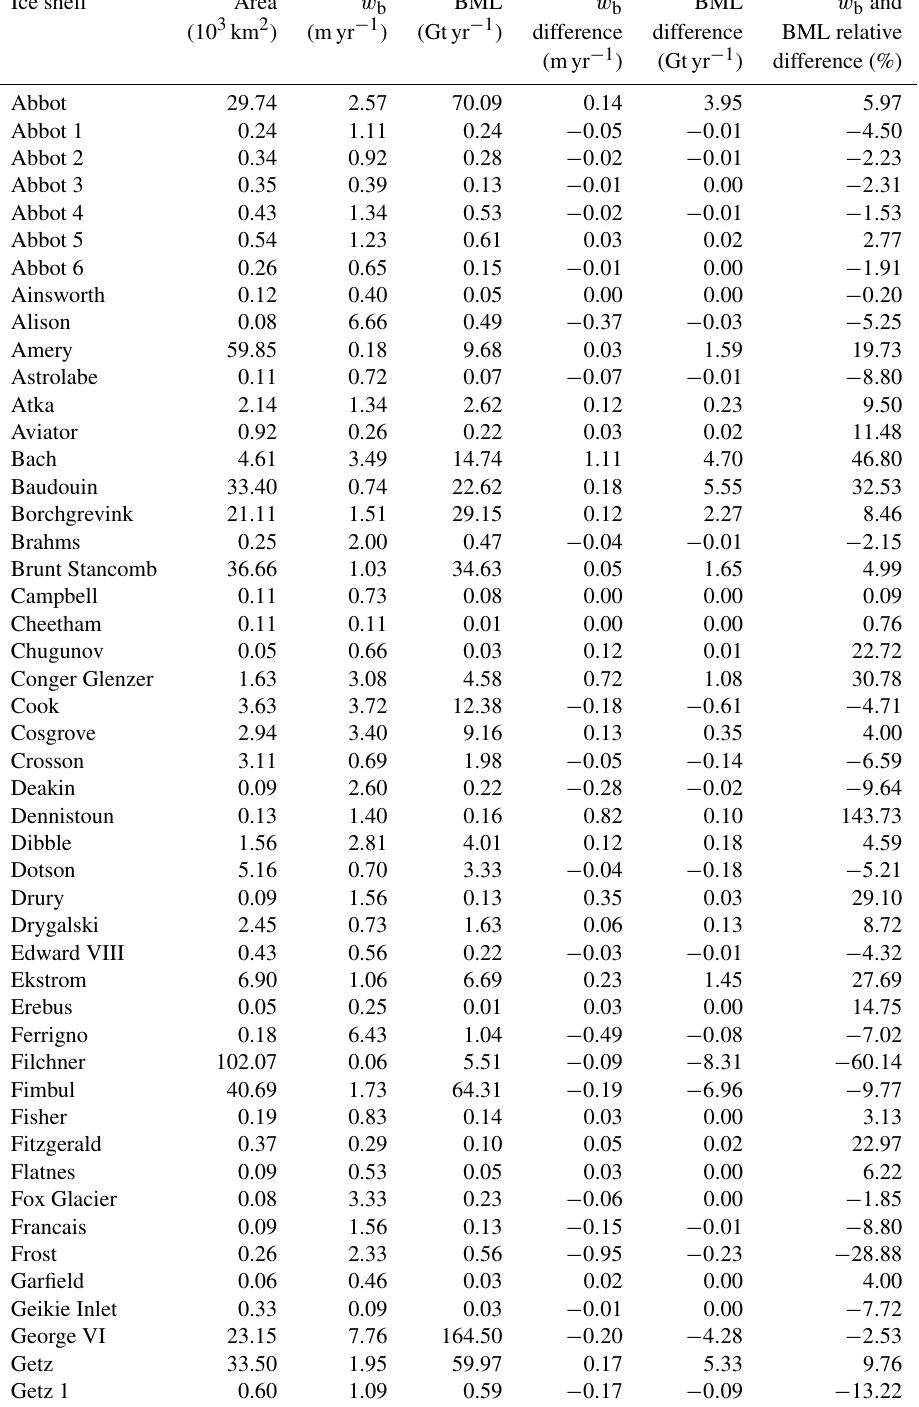
Table A1. Ice shelf average mass loss due to tides. For 139 individual ice shelves the table shows the area, melt rate ( w b ) and basal mass loss (BML) of the run with tides, as well as its difference to the run without tides in absolute (e.g. w btides − w bno-tides ) and